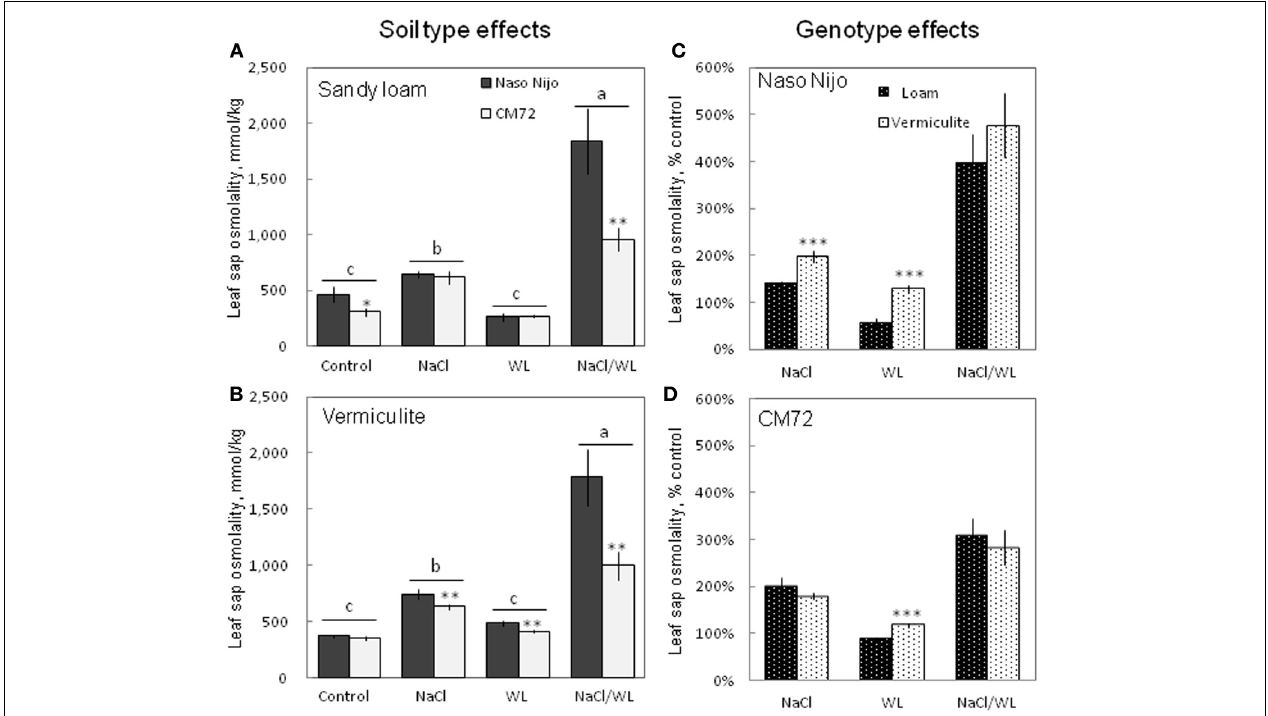
the Materials and Methods section. Mean ± SD ( n = 5). Different lower case letters indicate the significant difference between treatments (averaged for both genotypes) at P < 0 . 01. Asterisks indicate the significant difference between cultivars within the treatment at ∗ P < 0 . 01, ∗∗ P < 0 . 001 and ∗∗∗ P < 0 .